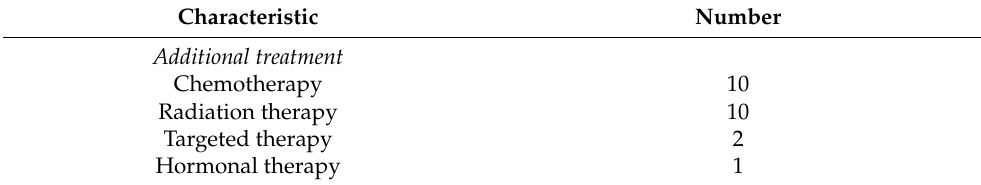
Table 1. Cont. Characteristic Number Additional treatment Chemotherapy 10 Radiation therapy Targeted therapy